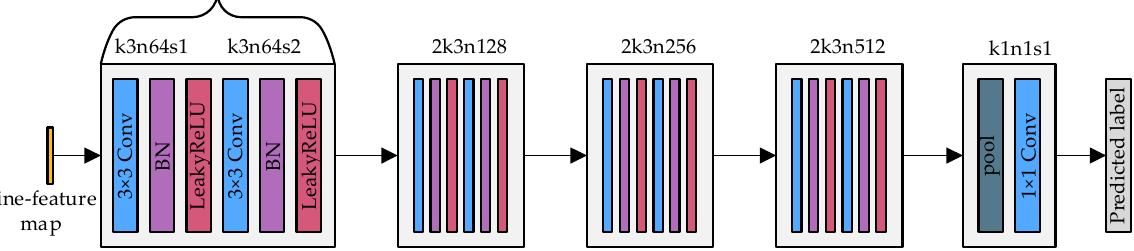
Figure 4. The network architecture of the discriminator. The discriminator network is similar to the VGG11 [41] network, using fine-feature maps as network input.